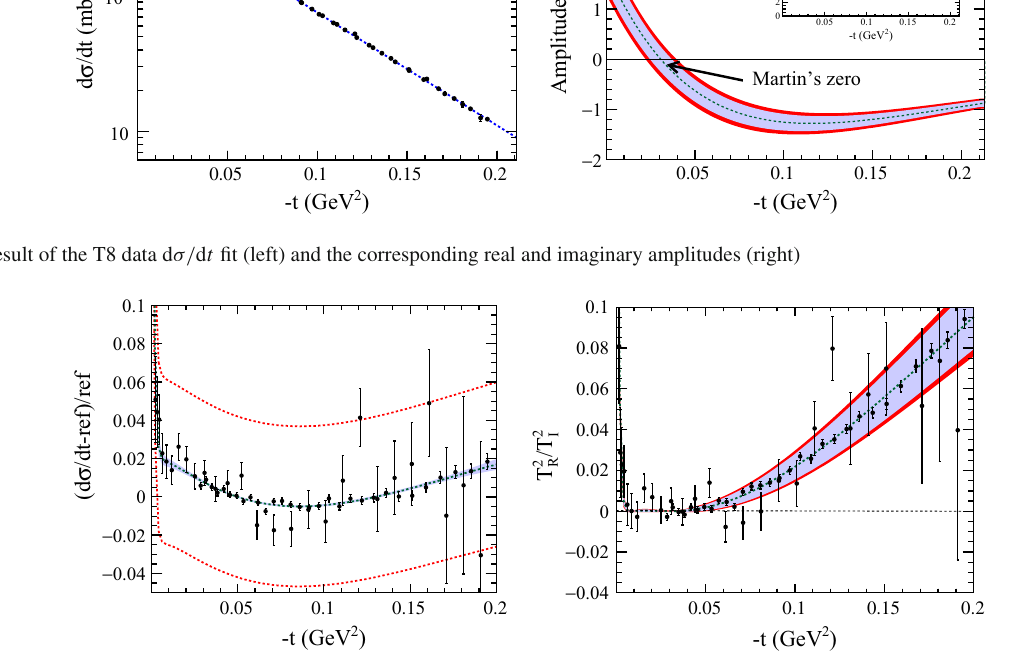
Fig. 2 The left plot shows the non-exponential behavior of the differ- ential cross section for T8. The figure is obtained subtracting from the best fit of the differential cross section a reference function which is d σ/ d t written with a pure exponential form and dividing the subtrac- tionbythisreferencefunction.Thedashedlinesshowthenormalization error band in d σ/ d t , which is quite large. The plot in the RHS shows the